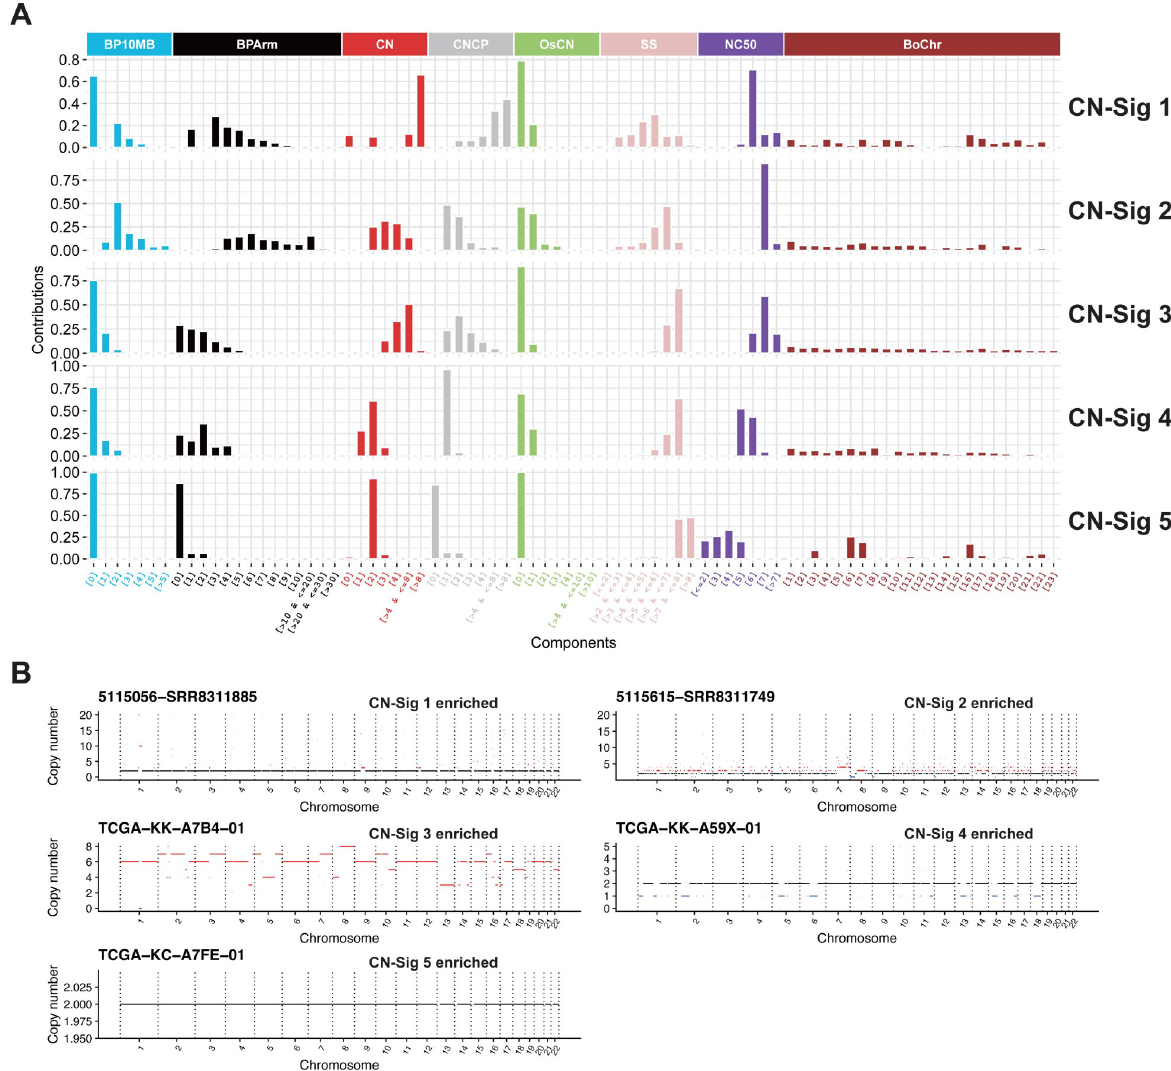
Fig 2. Copy number signatures identified in PC. (A) Five copy number signatures are identified from PC WES data. For copy number signatures, the signature profile was row normalized within each feature. Copy number signature has 8 different features with 80 components in together. (B) Representative absolute copy number profile for each copy number signature. Selected samples with enriched copy number signature CN-Sig 1, CN-Sig 2, CN-Sig 3, CN-Sig 4 and CN-Sig 5 are shown. The segments with copy number gain and loss are labeled by red and blue color,